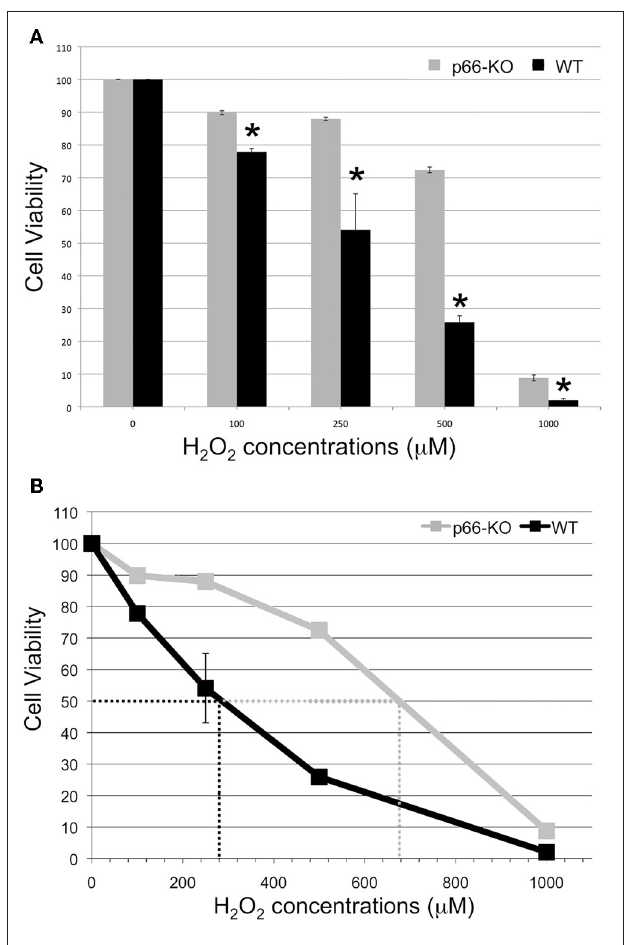
FIGURE 1 | p66-KO neurons are more resistant to H 2 O 2 treatment compared to WT neurons. Week-old p66-KO and WT hippocampal neurons were treated with various concentrations of H 2 O 2 (100, 250, 500 μ M, and 1mM) for 15min. Cell counts were obtained 24h post-treatment using Calcein AM as a viability indicator. (A) Cell viability percentages were significantly greater for the p66-KO neurons compared to the WT neurons for the tested H 2 O 2 concentrations ( ∗ = p < 0 . 05). (B) H 2 O 2 concentration vs. survival percentage curves showed that the EC50 for 50% survival was approximately 280 μ M for WT neurons and 680 μ M for p66-KO neurons, demonstrating that p66 elimination is associated with increased resistance to H 2 O 2 treatment ( n per treatment/genotype = 3 cultures; 4